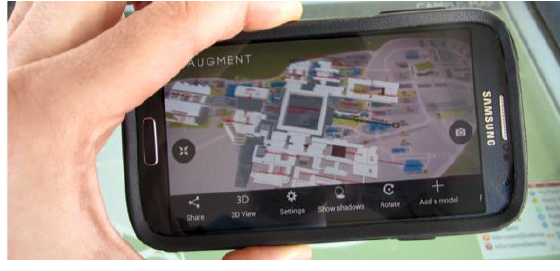
Figure 2. Augmented campus